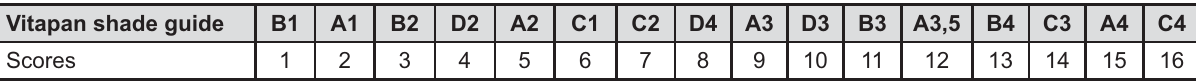
Figure 1- Color scores by sequence of colors in the shade guide (from lighter to darker